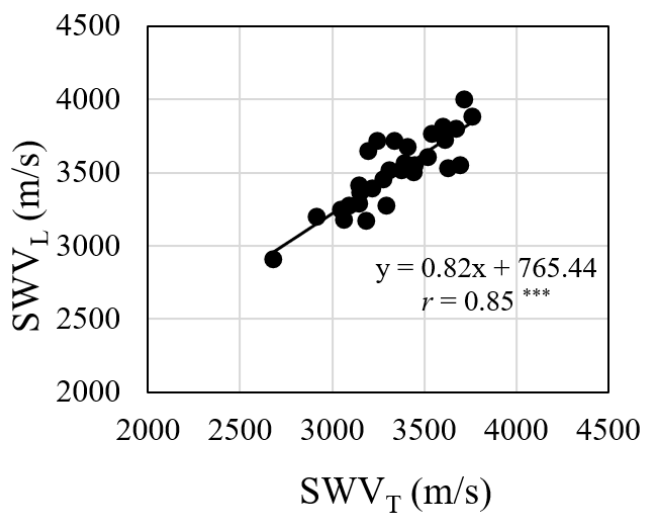
Figure 3. Relationship between stress wave velocities measured on standing trees (SWV T ) and logs (SWV L ) (***: p < 0.001). Table 3. Stress wave velocity and wood properties of six different Eucalyptus clones planted in